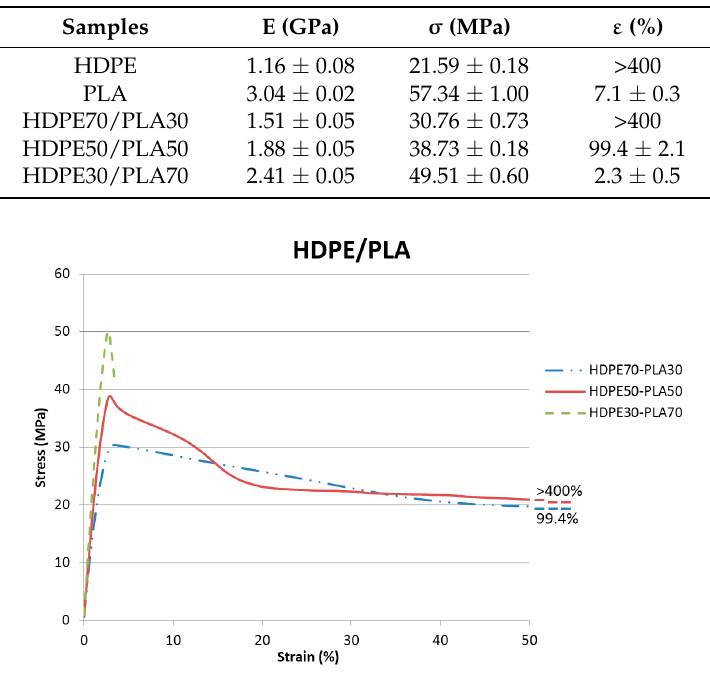
Figure 1. Tensile tests graphs of HDPE70/PLA30, HDPE50/PLA50, and HDPE30/PLA70.